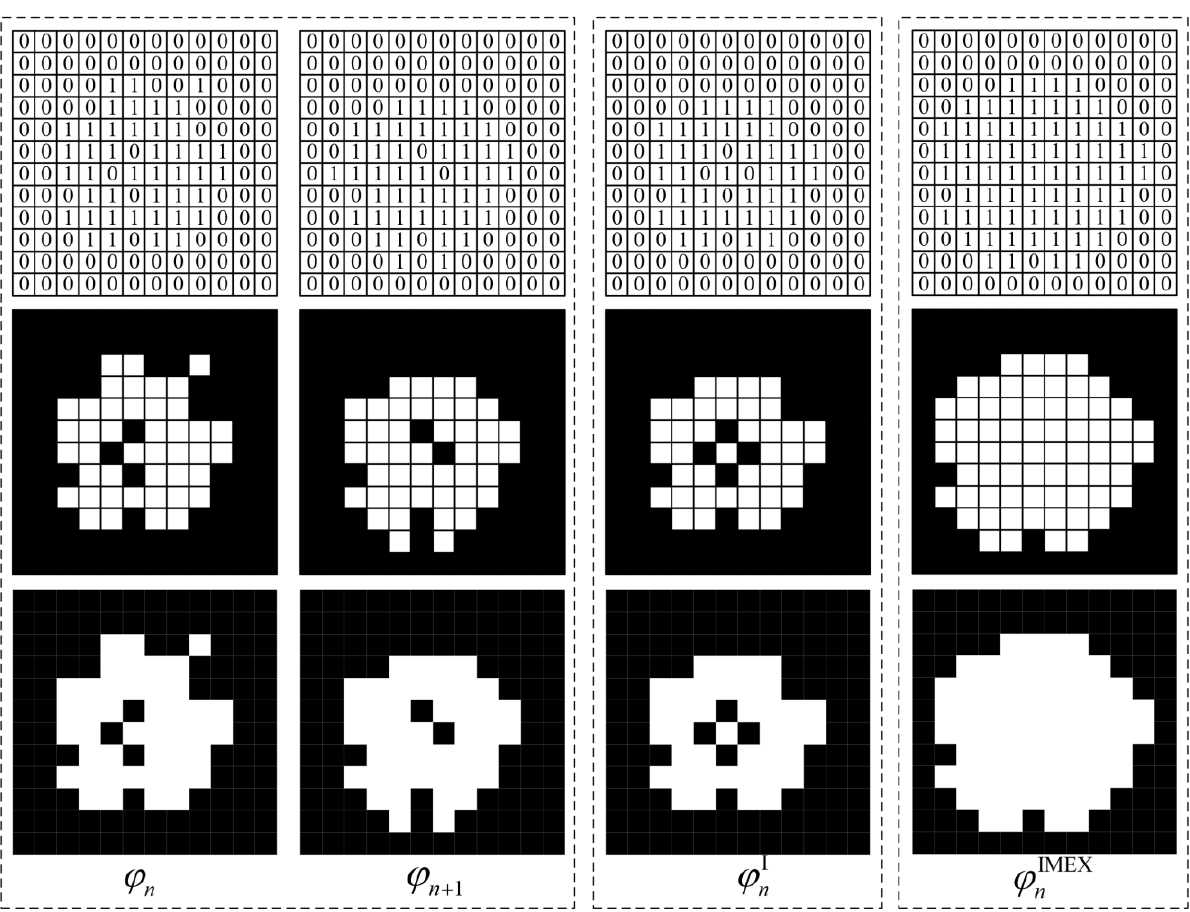
Figure 3. Schematic diagram of Algorithm 1 (IMEX).